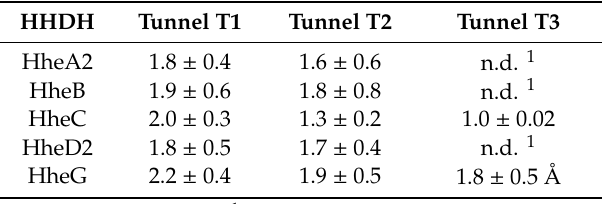
Table 1. Mean tunnel bottleneck radius (BR, in Å) for each HHDH system computed on a representative structure of each cluster center (see Methods).